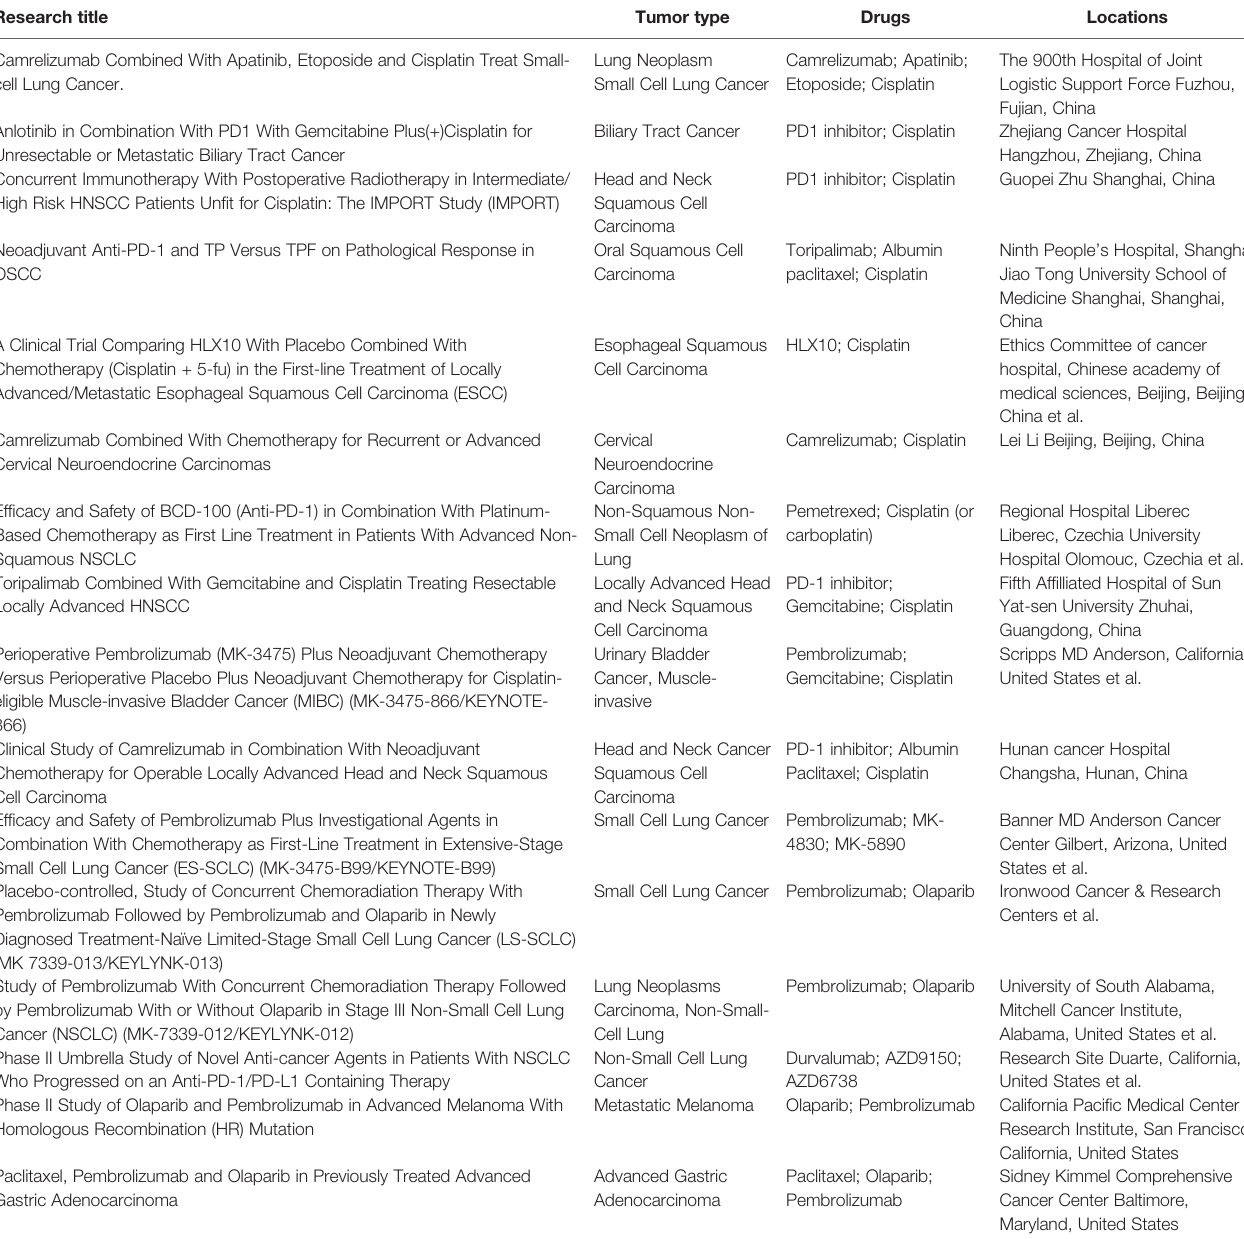
TABLE 2 | Ongoing clinical trials on DDR-related drugs with